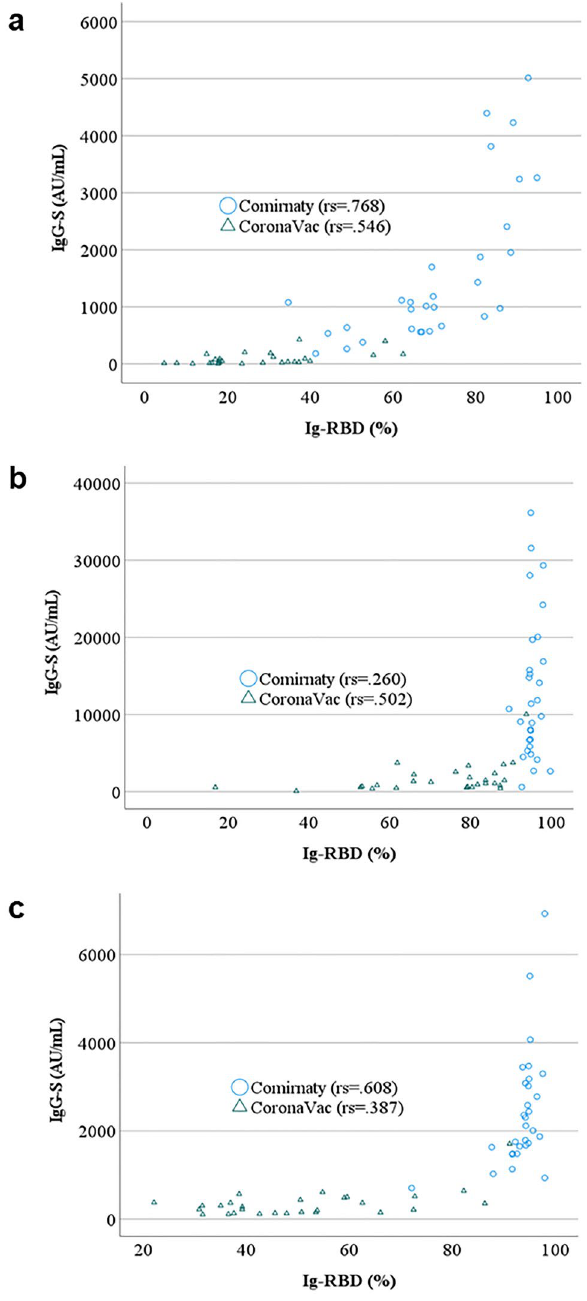
Figure 2. Correlation between IgG-S and Ig-RBD of Comirnaty (n = 30) and CoronaVac (n = 28) recipients. IgG-S was determined using SARS-CoV-2 IgG Quant II (Abbott) and Ig-RBD determined using the cPASS surrogate virus neutralization test (Genscript). Spearman rank-order correlation coefficient is represented as rs. ( a ) Week 3, ( b ) Week 6 and ( c ) Week